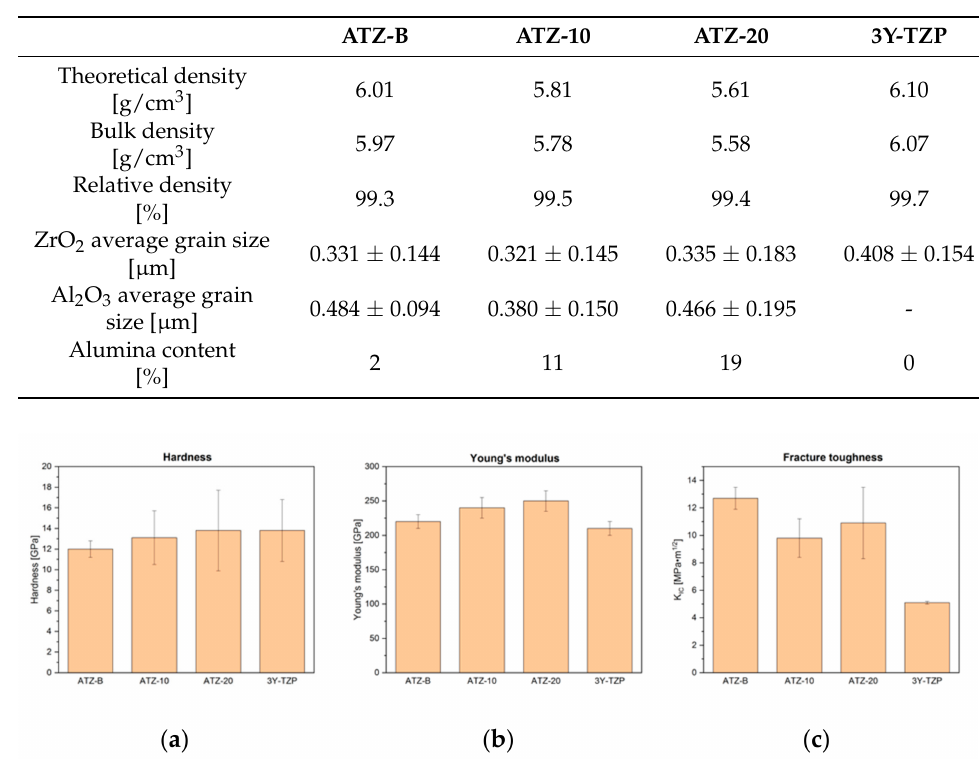
Figure 1. On the left side: SEM images of thermally etched ( a ) ATZ-B, ( b ) ATZ-10, ( c ) ATZ-20 composites and ( d ) 3Y-TZP reference material; on the right side: their binarized counterparts. Table 2. Density and grain sizes of the investigated ATZ ceramics.